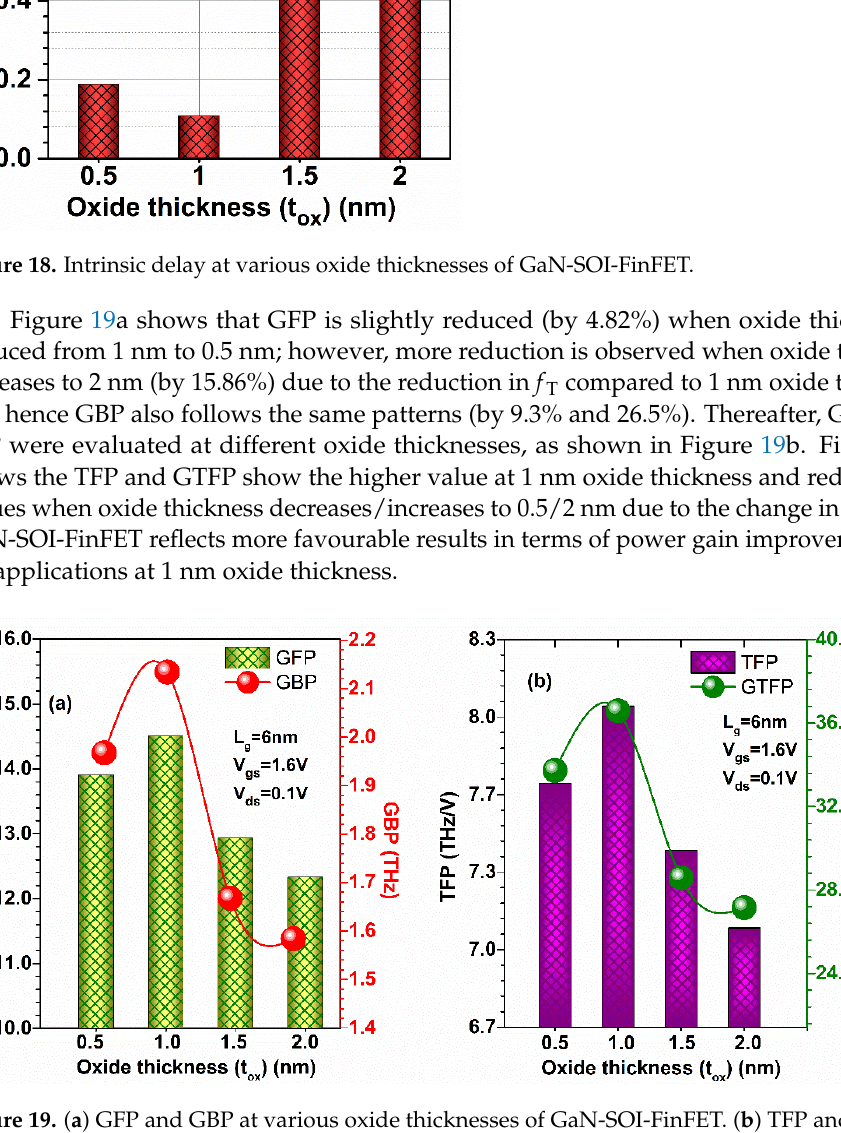
Figure 17. ( a ) f T and ( b ) f MAX at various oxide thicknesses of GaN-SOI-FinFET.